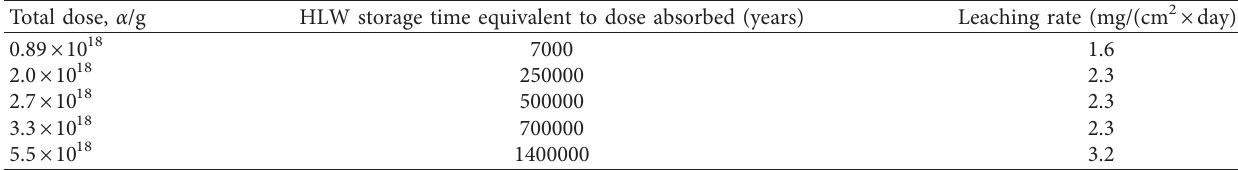
2 additive as source of α -radiation [51, 52].